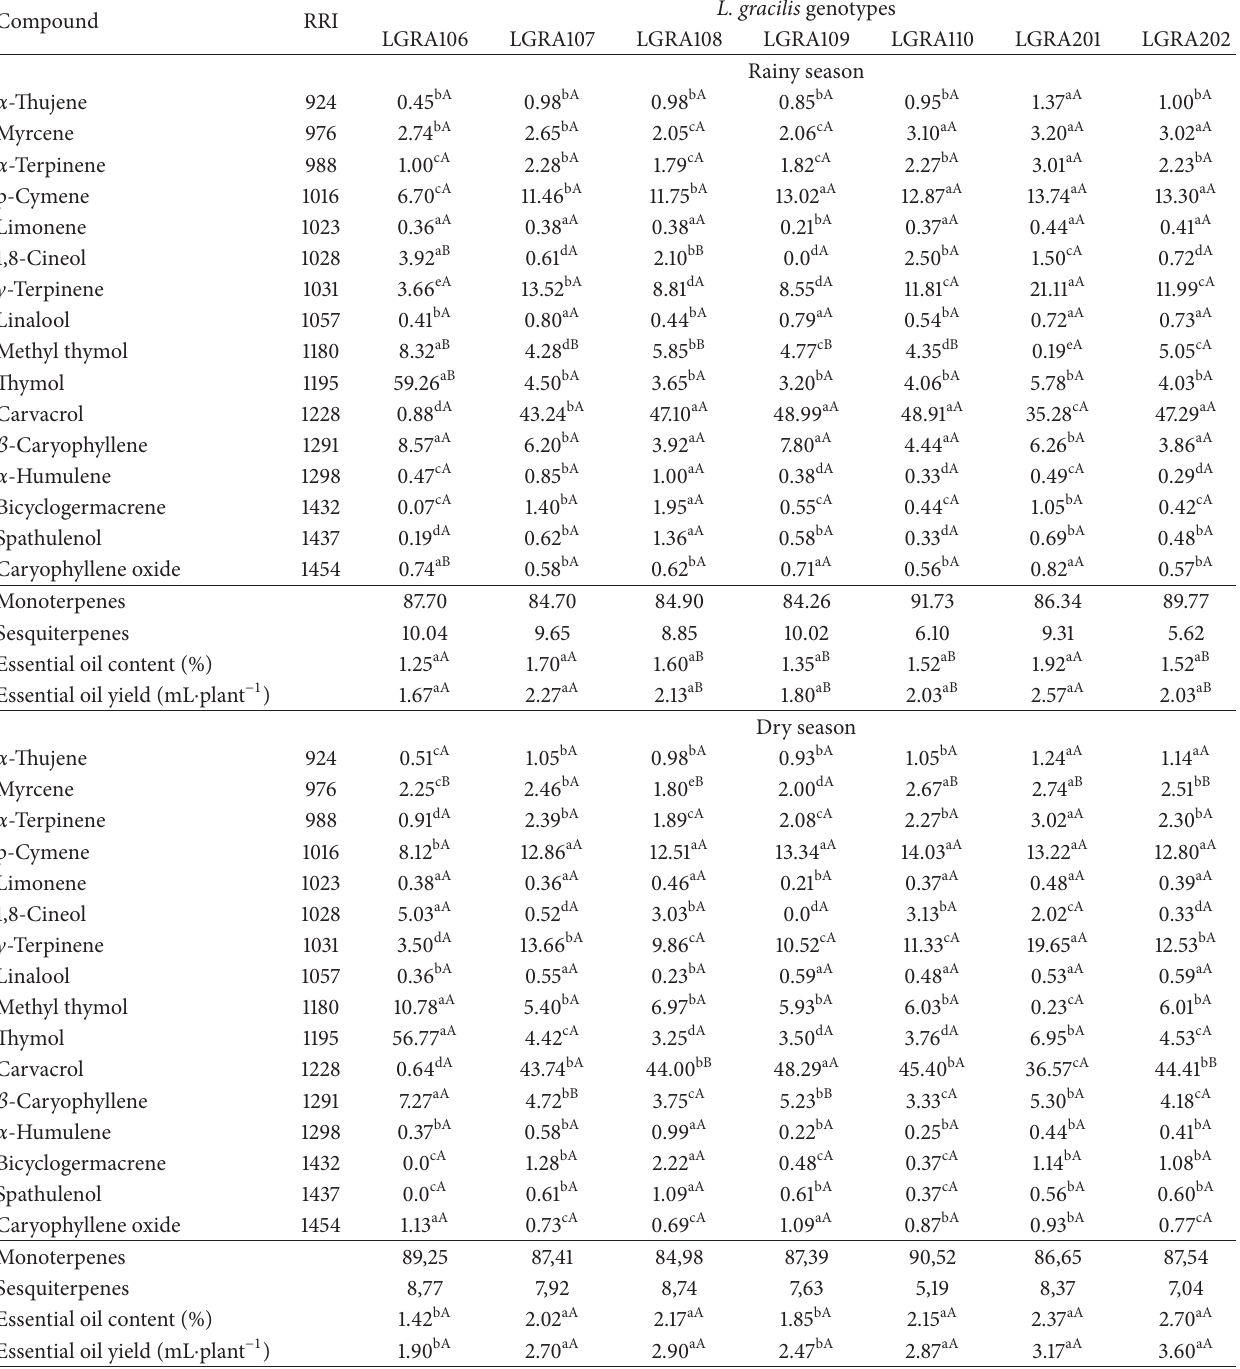
Table 2: Chemical composition (%) of the essential oil of L. gracilis genotypes harvested in rainy and dry season. Compound